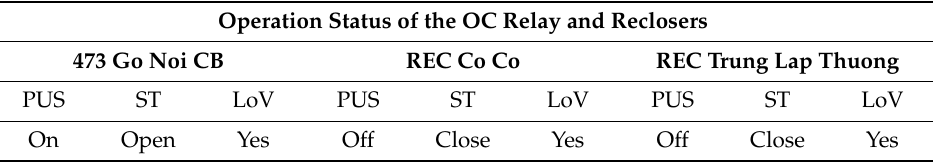
Table 12. The operation status of the OC relay and reclosers with respect to the fault F1. Operation Status of the OC Relay and